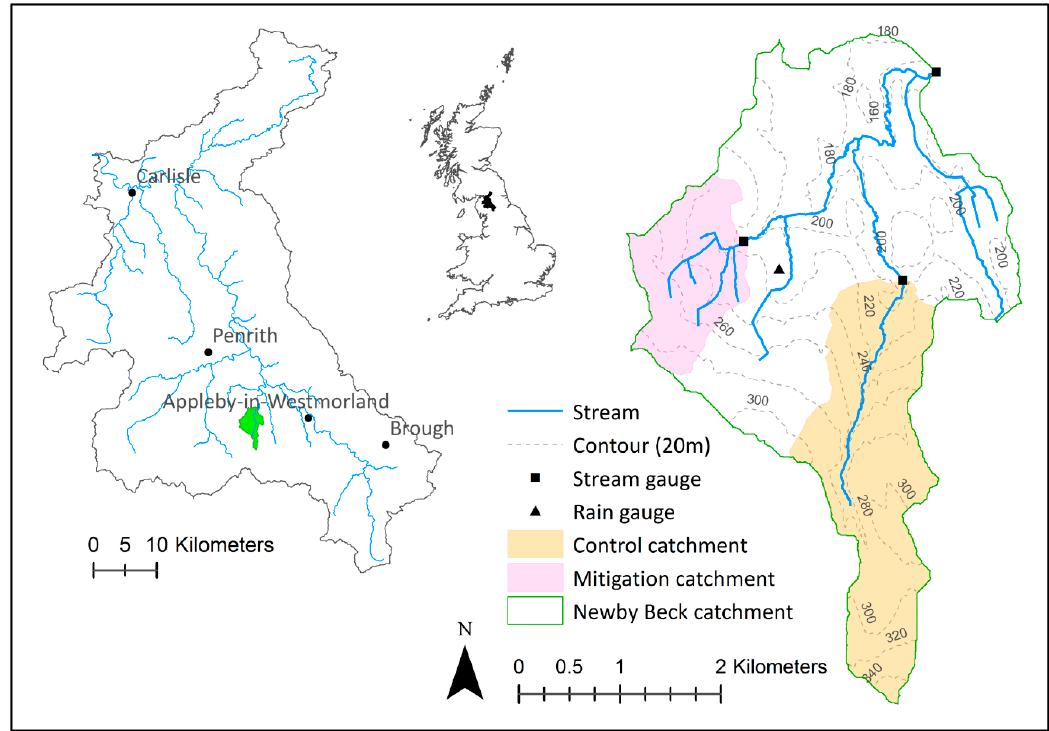
Figure 1. Map of the Eden catchment showing the NBC sub-catchment studied as part of the EdenDTC project, and the location of the monitoring sites for rainfall and flow in the sub-catchments. Contours at 20 m intervals depict the topography.